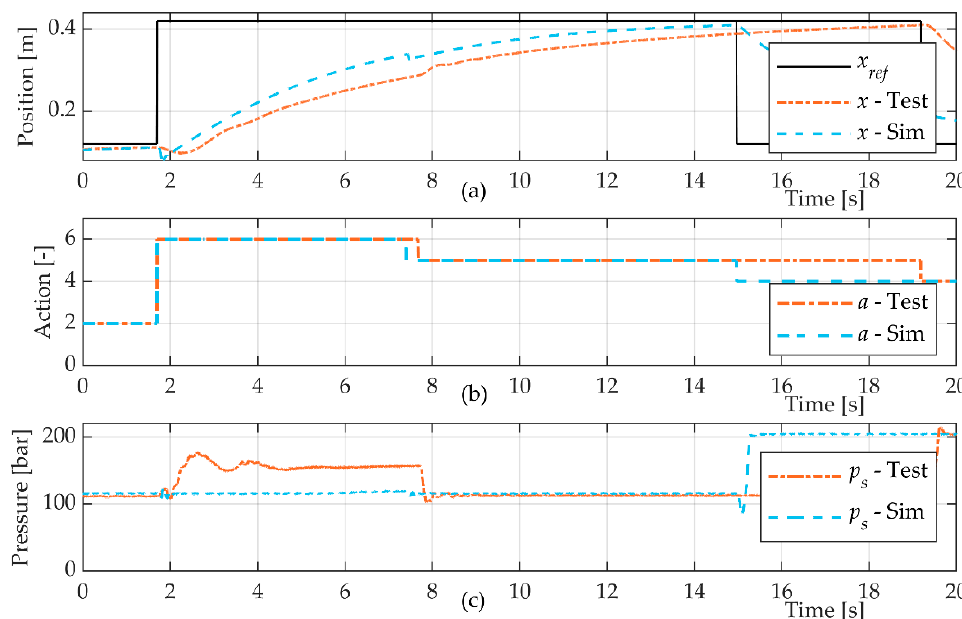
Figure 12. Experimental (Test) and simulation (Sim) results, 40 kg load and p LS ,1 = 100 bar. ( a ) Position and reference; ( b ) action; ( c ) system pressure.